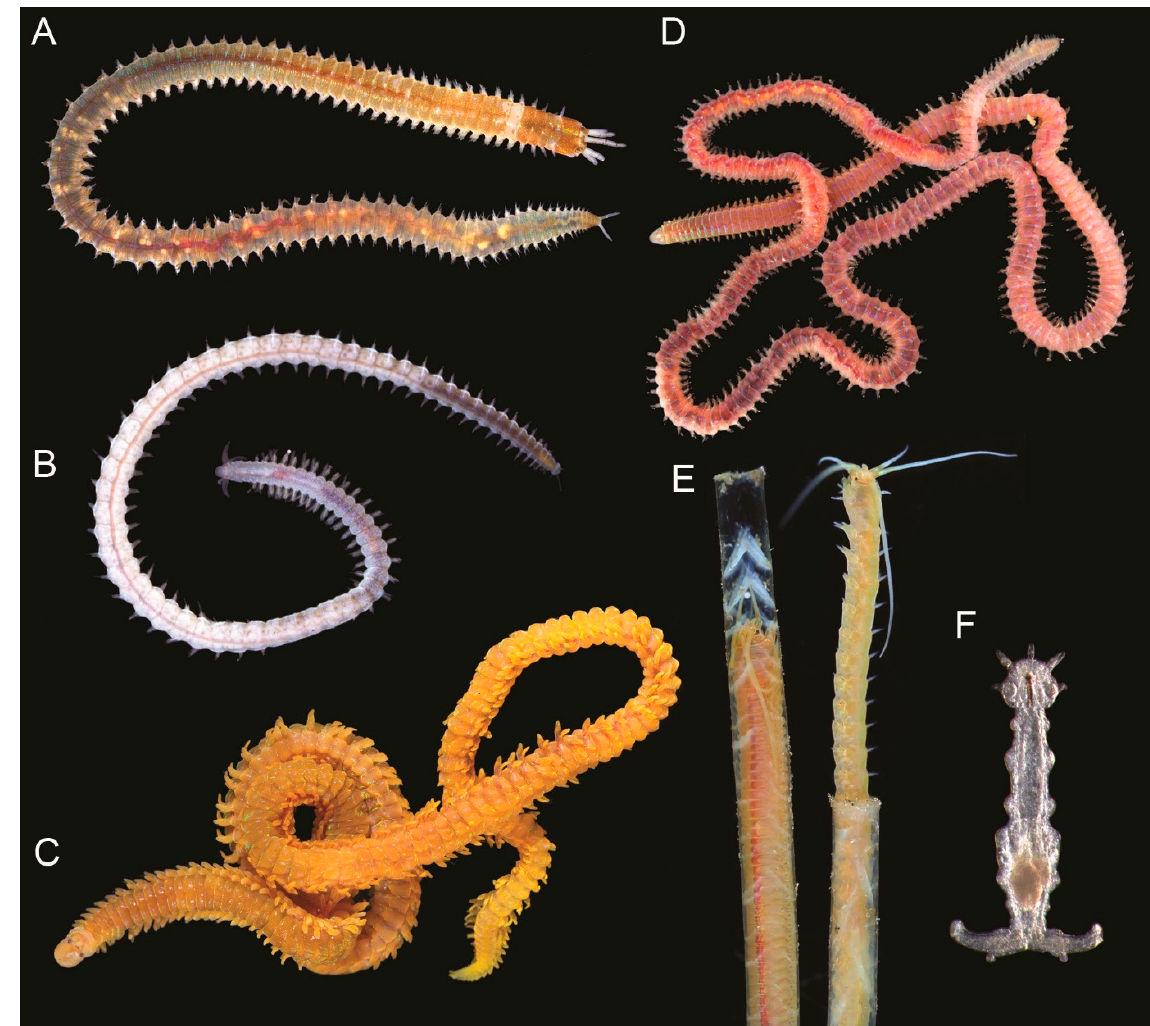
Figure 1. Live specimens representing eunicidan families: ( A ) Nicidion sp., Eunicidae, © A. Sememov; ( B ) Dorvilleidae gen. sp., © A. Sememov; ( C ) Oenone fulgida (Lamarck, 1818), Oenonidae, © A. Sememov; ( D ) Lumbrineridae gen. sp., © A. Sememov; ( E ) Hyalinoecia tubicola (O.F. Müller, 1776), Onuphidae, © N. Budaeva; ( F ) Histriobdella homari Van Beneden, 1858, Histriobdellidae, © C. Helm.